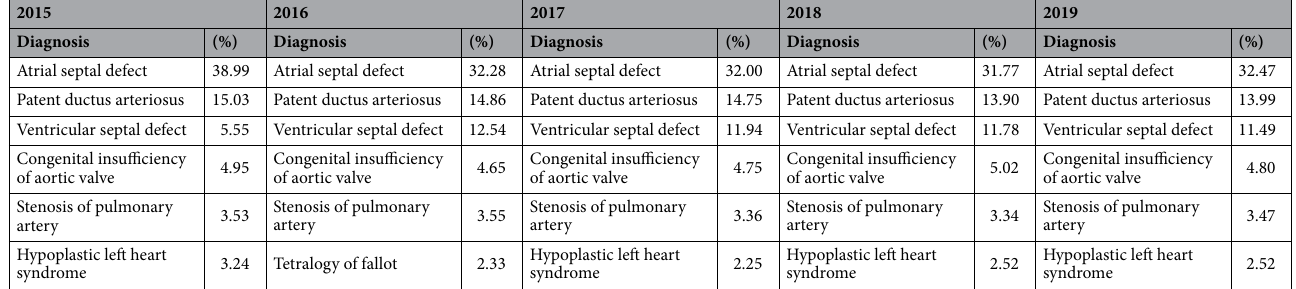
Table 3. Most common cardiac diagnoses codes in patients with congenital heart disease presenting for a surgical